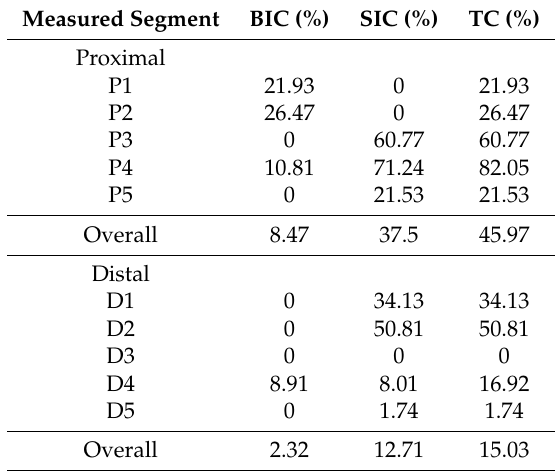
Table 1. Measurements for the 3D-printed implant and bone contact